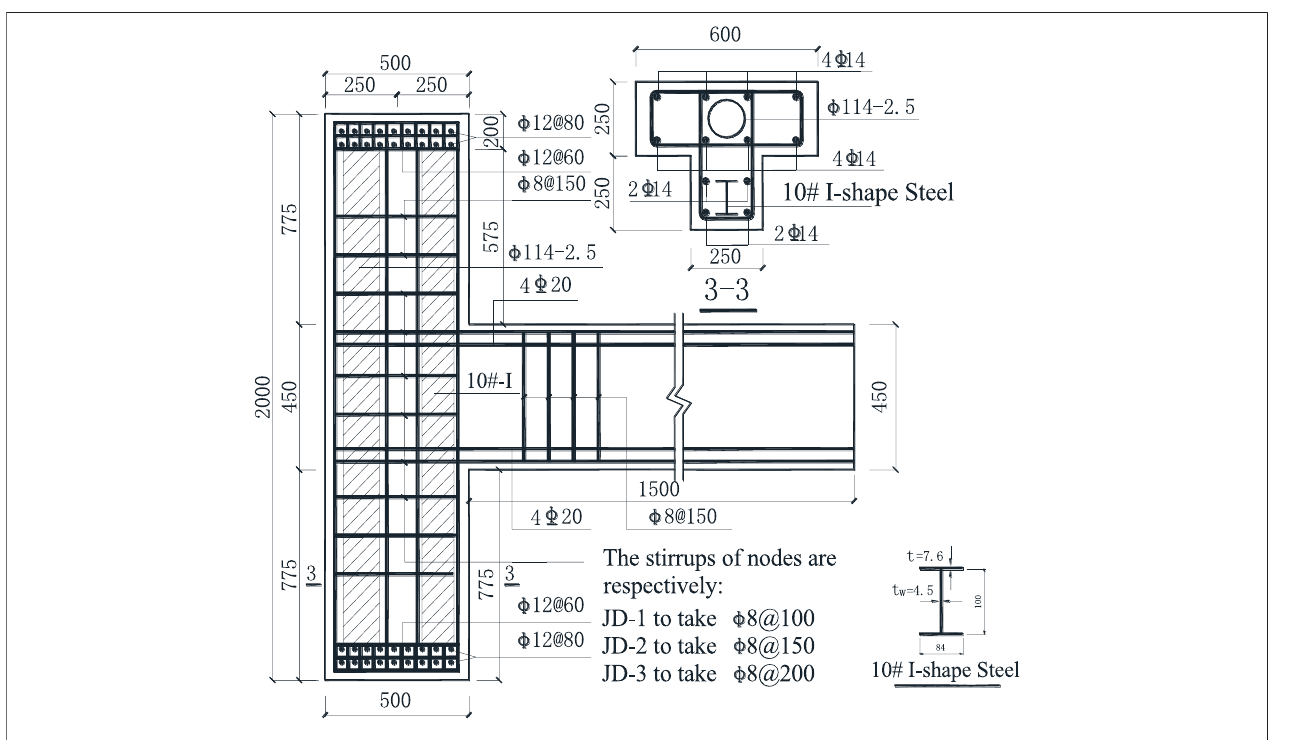
FIGURE 10 | Reinforcement of specimen JD-1 – JD-3 (Xiang et al., 2017; Xiang et al., 2019).